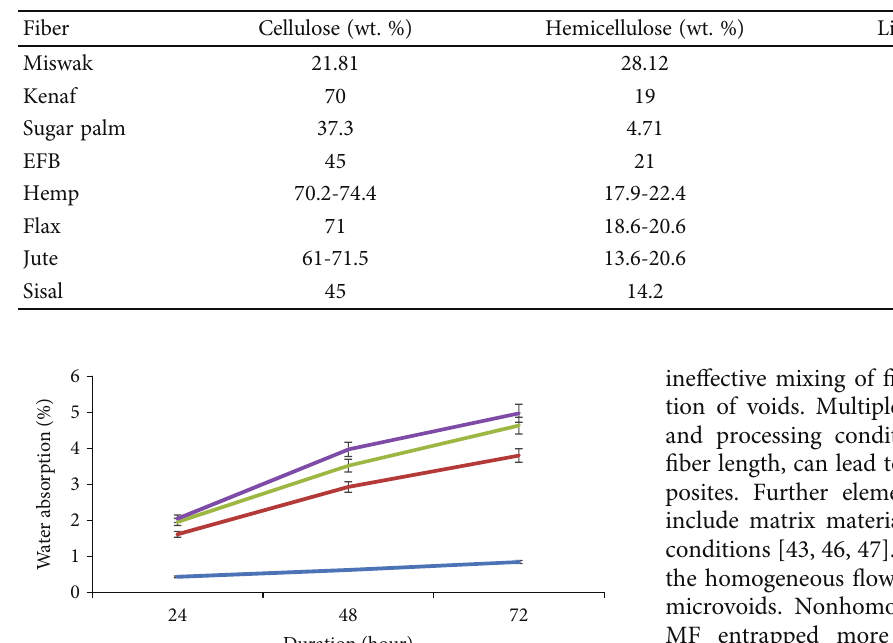
Table 3: Constituents of miswak fi ber and other natural fi bers.